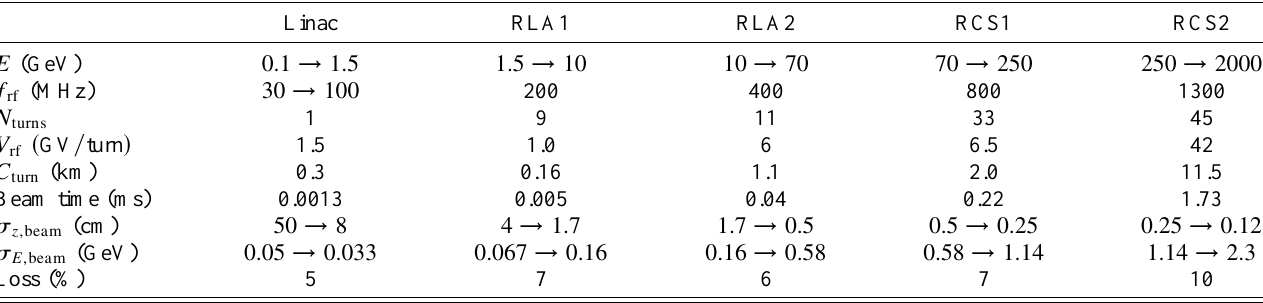
TABLE XI. Parameters of acceleration for a 4 TeV